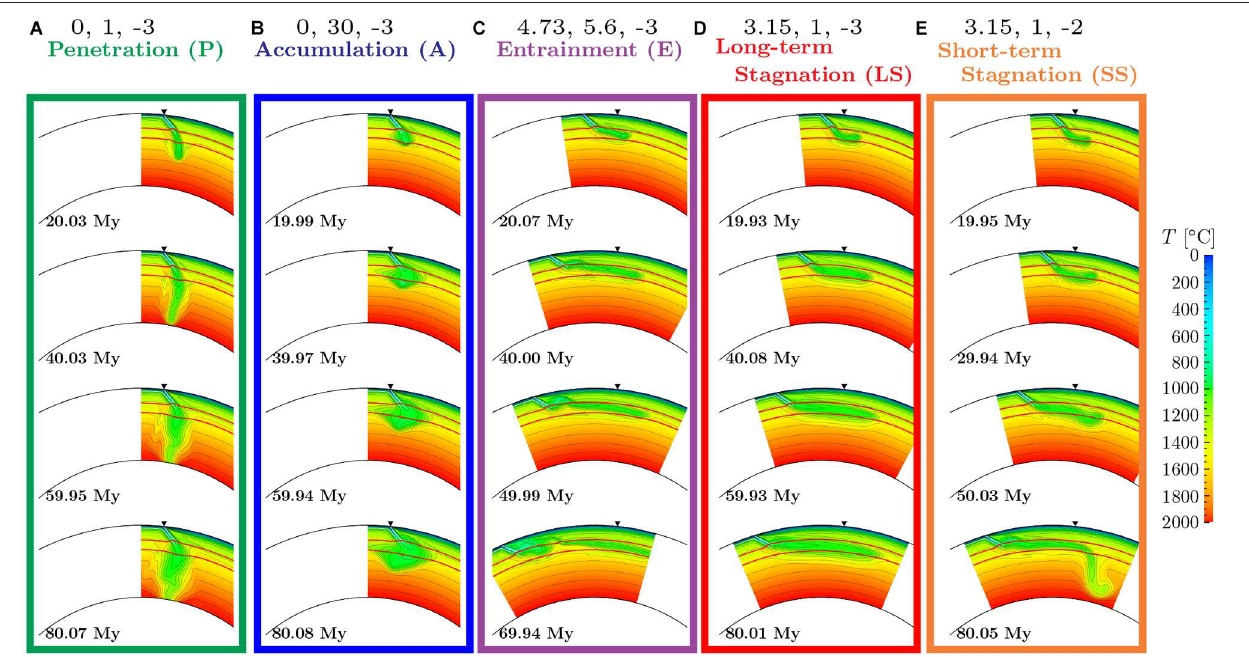
FIGURE 3 | Comparison between the evolution of five types of subducting slab morphologies: (A) Penetration (green), (B) Accumulation (blue), (C) Entrainment (purple), (D) Long-term Stagnation (red), and (E) Short-term Stagnation (orange). Indicated at the top of respective frames are the trench retreat velocity v tr [cm/yr], the viscosity jump between the upper and lower mantle r η , and the Clapeyron slope at the 660 km discontinuity γ 660 [MPa/K] for each case, respectively. The meaning of the colors, contour lines, red and white lines, and black triangles are same as in Figure 2 .